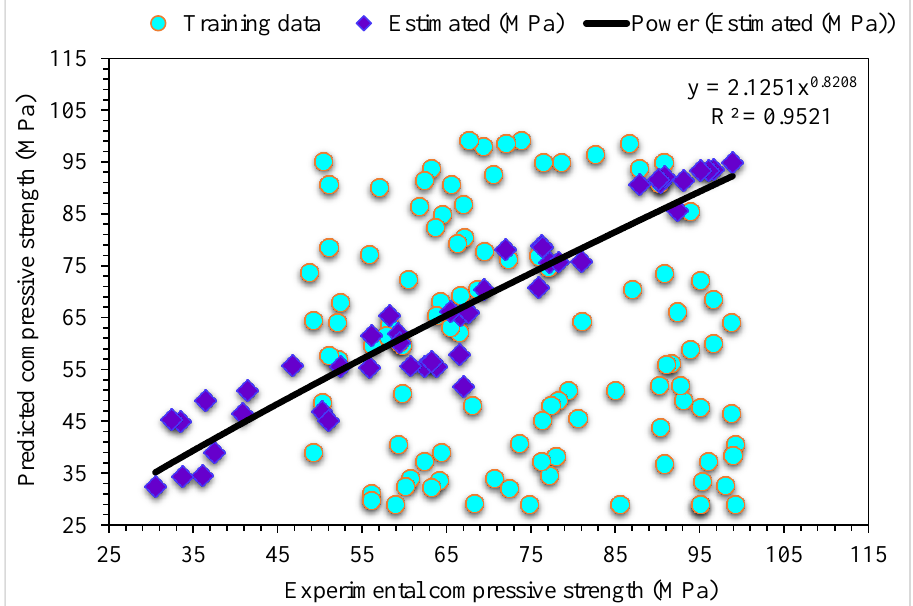
Figure 8. Experimental and MLPNN-AdaBoost predicted results for compressive strength.